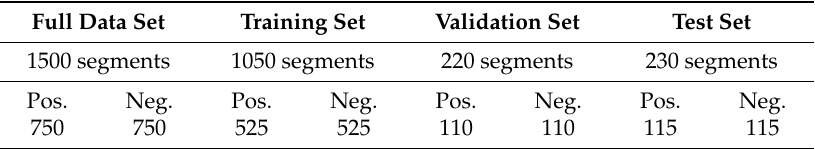
Table 2. Training and testing set for obstacle-recognition library implementation.